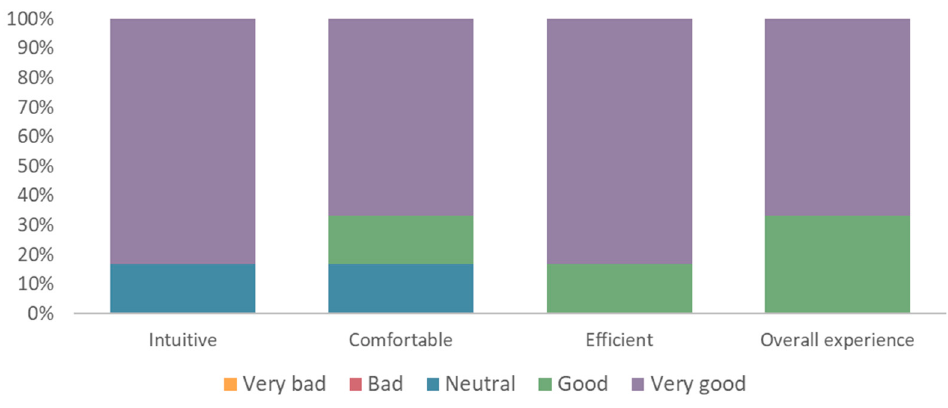
Figure 6. Results from the survey regarding the evaluation of the interaction with ChatGPT. The possible uses proposed by the surveyed participants ranged from initial consulting, safety and risk identification, basic design, cost estimation, processing and evaluation of contracts, or identifying